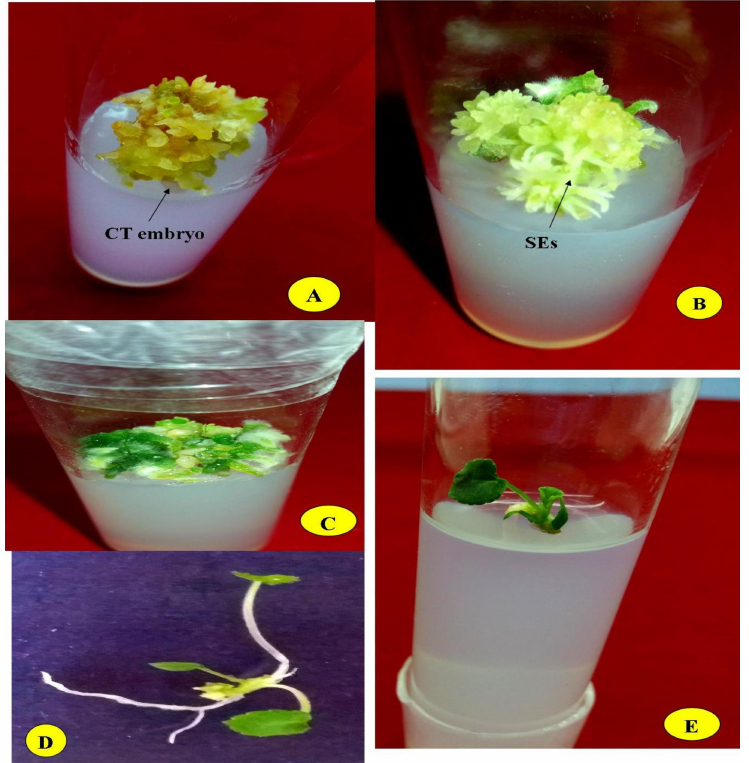
Figure 1. Plant regeneration through somatic embryogenesis in V. canescens from leaf explants. ( A ) Asynchronous SE on Murashige and Skoog (MS) medium 0.15 + 0.05 mg L − 1 (2,4-D + Kn). ( B ) SE on MS medium supplemented with casein hydrolysate + L -glutamine (2 % + 50 mg L − 1 ). ( C ) Mature SE. ( D , E ). Plantlets regenerated from mature